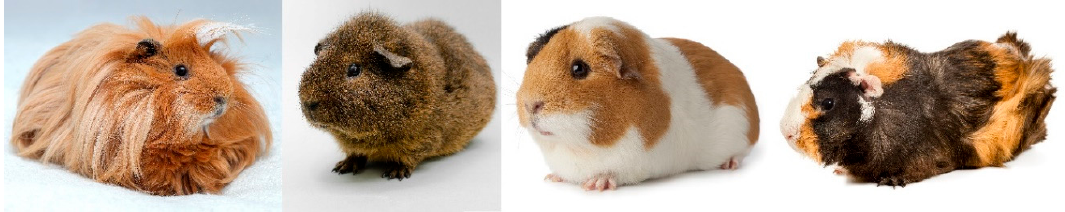
Figure 3. Guinea pig races with their different fur forms: (from left to right) longhaired guinea pigs, Rex guinea pigs, smooth-haired guinea pigs, curly-coated guinea pig (shutterstock.com/free-license images). Table 3. Age distribution among the sampled animals. Age of all animals (breedings) of animals positive for T. benhamiae (breedings) * of symptomatic pets (laboratory data)